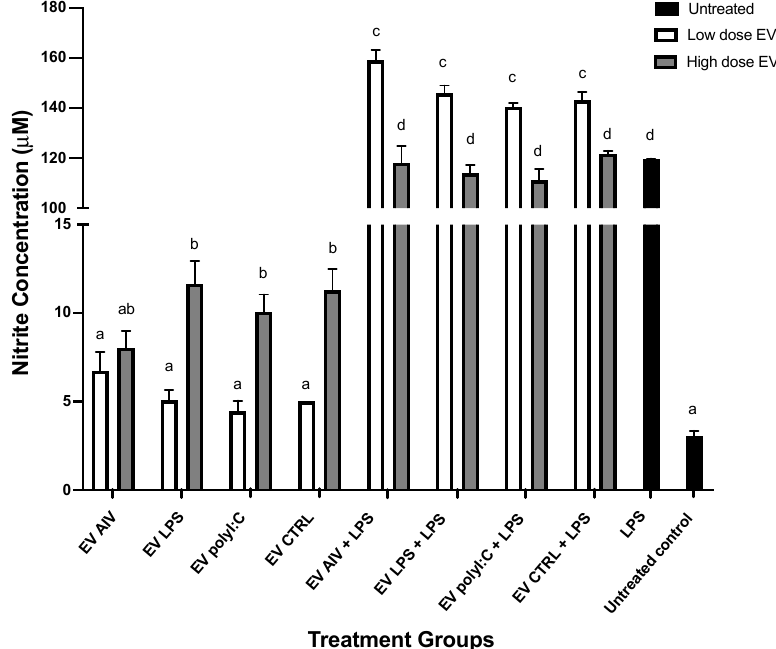
Figure 6. NO production by chicken macrophages stimulated with EVs. Macrophages were treated with either a low (5 µg/mL) or high (50 µg/mL) dose of EVs, with or without LPS treatment. NO production was assessed by the Griess assay. Significant differences ( p -value < 0.05) are denoted by letters. Groups that are significantly different are represented by different letters. Groups with the same letters are not significantly different. The error bars represent the standard error of mean (SEM).